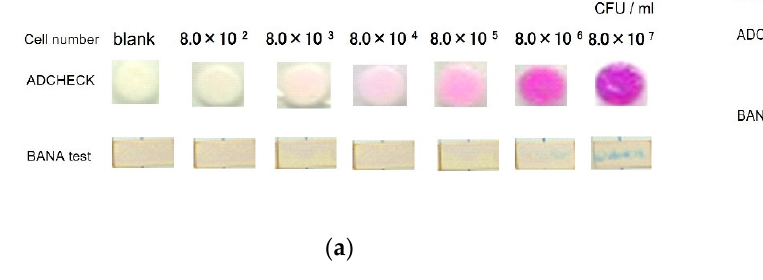
Figure 2. Detection of TLPs from cultured P. gingivalis bacterial strains by TLP-AA kit. The cell supernatants of each number of JCM12257 ( a ) and BAA-308 ( b ) in culture were examined by ADCHECK and BANA test. In the ADCHECK test, pink coloration was diagnosed as positive for TLP, while in the BANA test, the appearance of blue lines was diagnosed as positive for TLP.